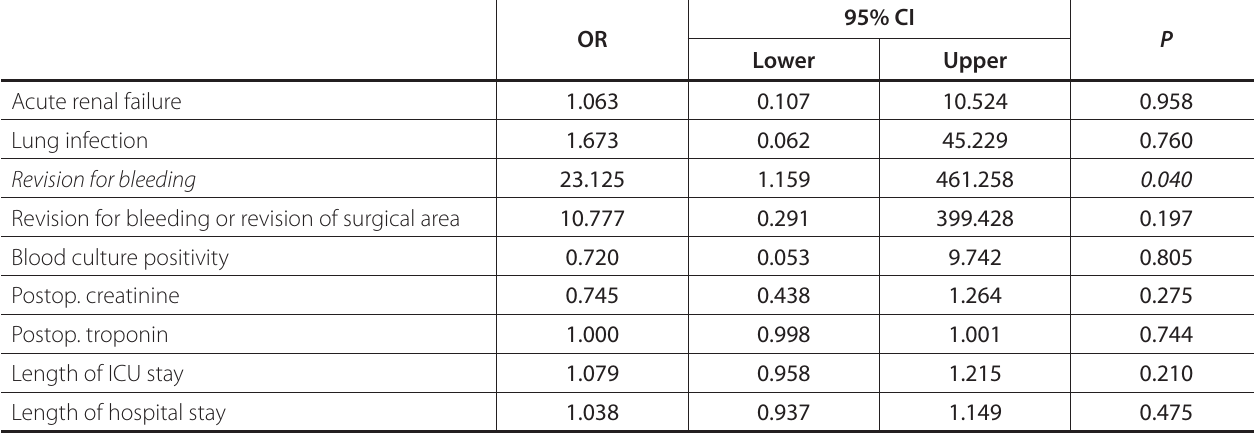
Table 6. Logistic regression analysis – postoperative factors.